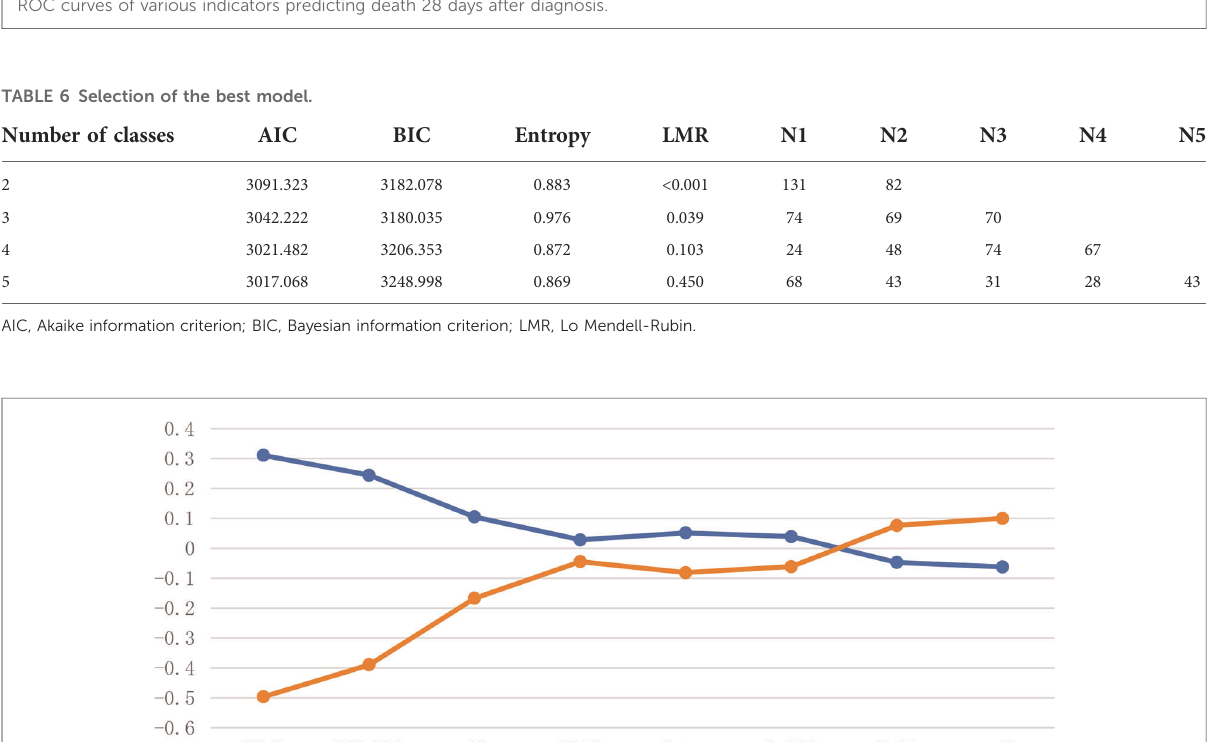
FIGURE 2 ROC curves of various indicators predicting death 28 days after